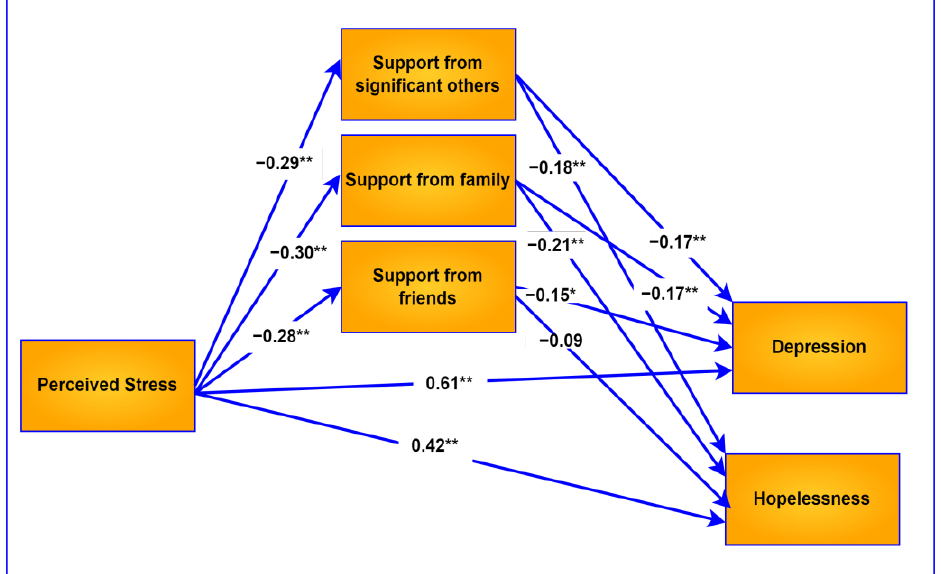
Figure 1. Conceptual model of the mediating role of social support. All regression coefficients are standardized. ** p < 0.001, * p < 0.01.